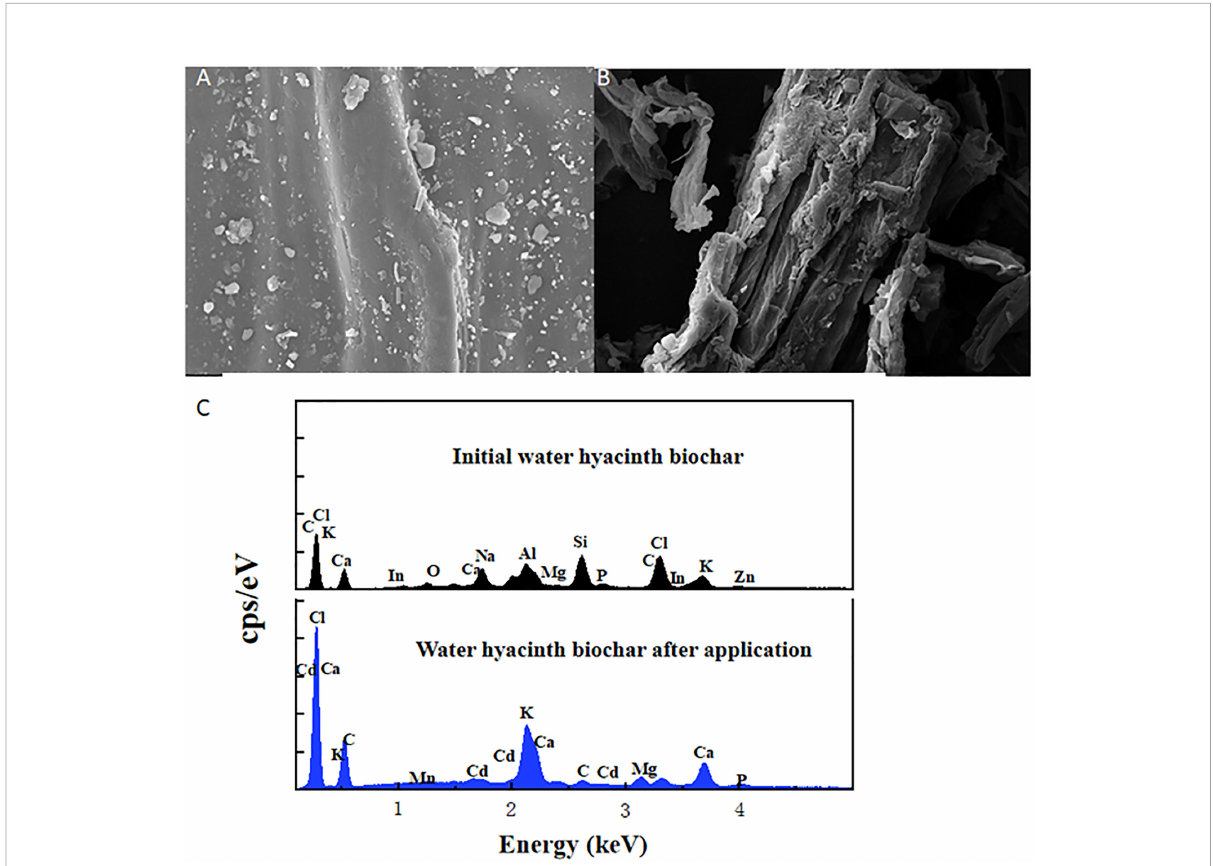
FIGURE 4 Comparison of the surface structure before and after application of water hyacinth biochar. (A) Initial water hyacinth biochar. (B) Biochar after being applied to soil on day 40. (C) EDS analysis of initial water hyacinth biochar and water hyacinth biochar after being applied to soil on day